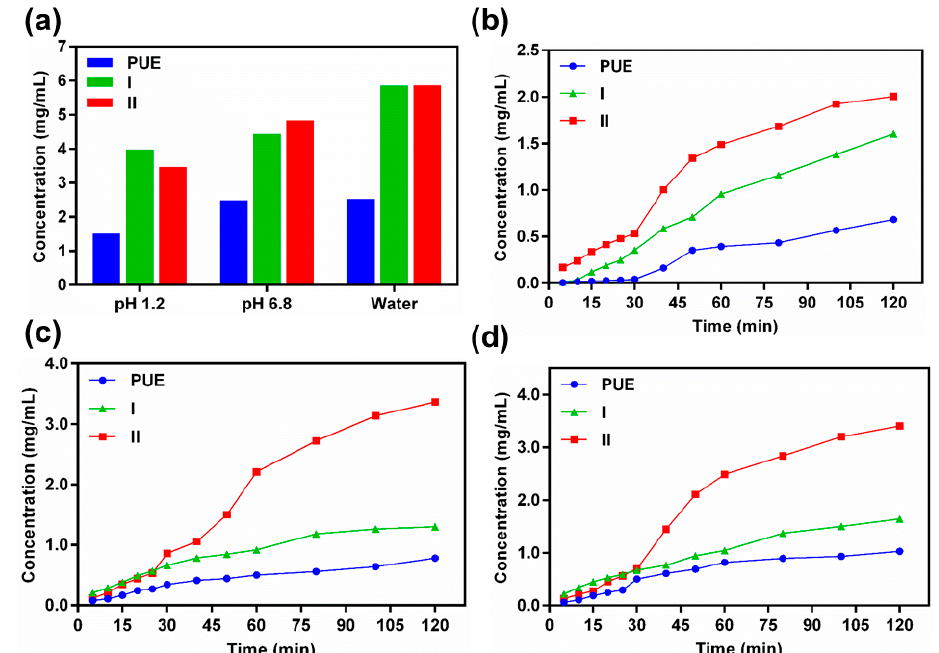
Figure 7. A summary of the solubility profile of PUE, I and II in the gastrointestinal tract at pH 1.2, phosphate buffer at pH 6.8, and H 2 O at pH 7.0 ( a ), as well as the time-dependent dissolution profile of these compounds under respective conditions: gastrointestinal tract at pH 1.2 ( b ), phosphate buffer at pH 6.8 ( c ), and H 2 O at pH 7.0 ( d ), reflecting the dissolution rate of each compound. Data are expressed as average values from three replicates.